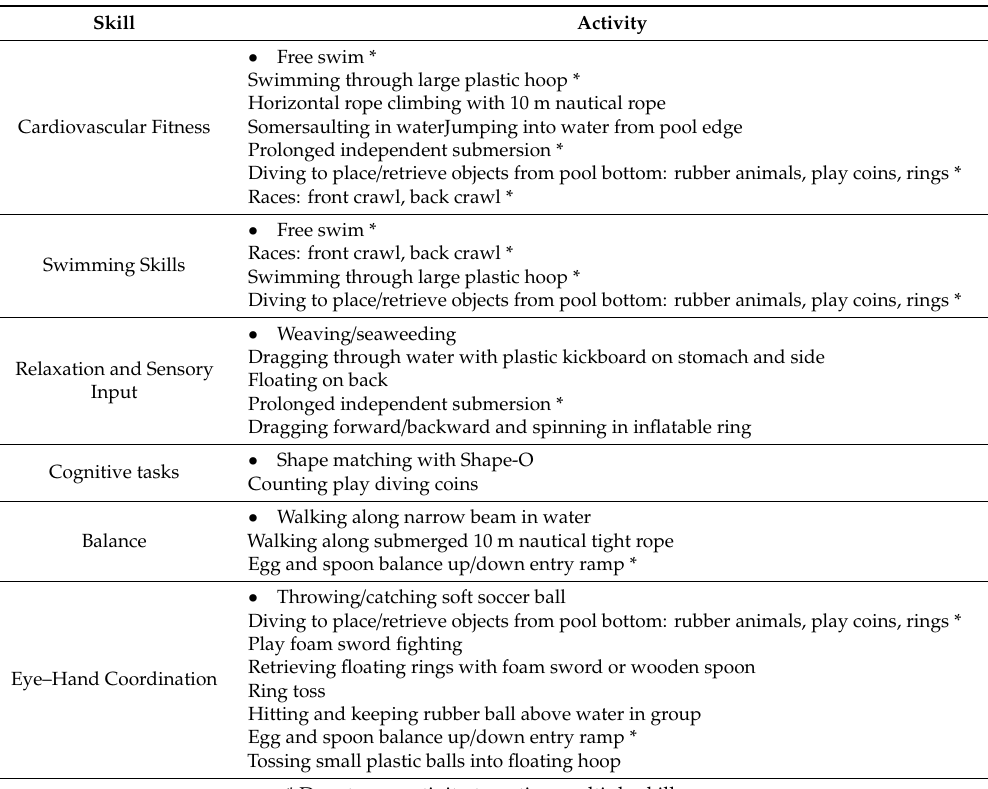
Table 2. Target skills, activities and equipment for hydrotherapy